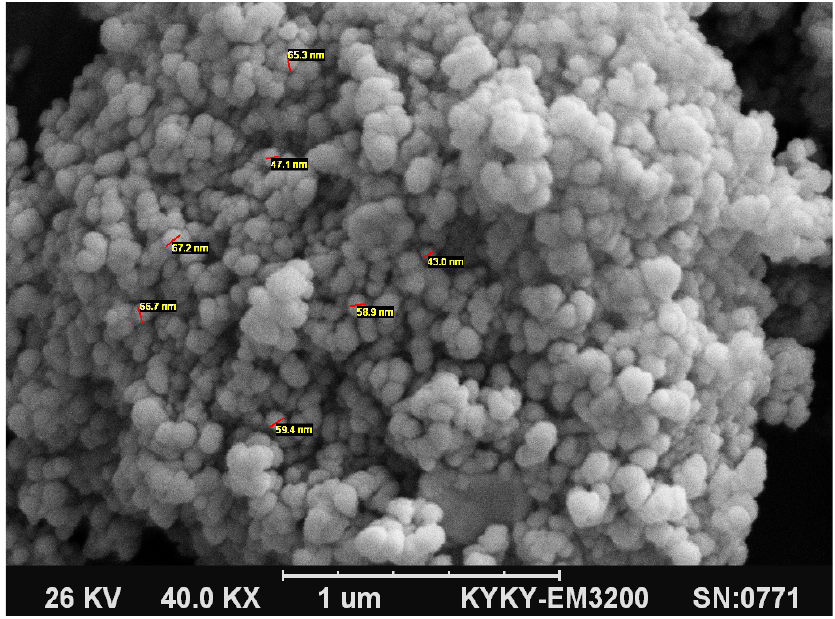
Fig. 1. Scanning electron microscopy of Polyaniline nano-adsorbent